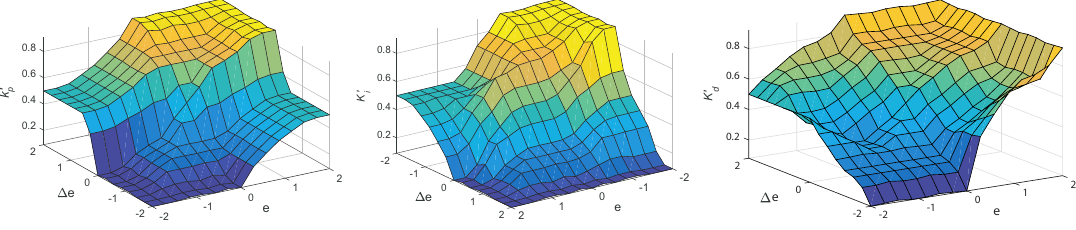
, and K (cid:48) i d